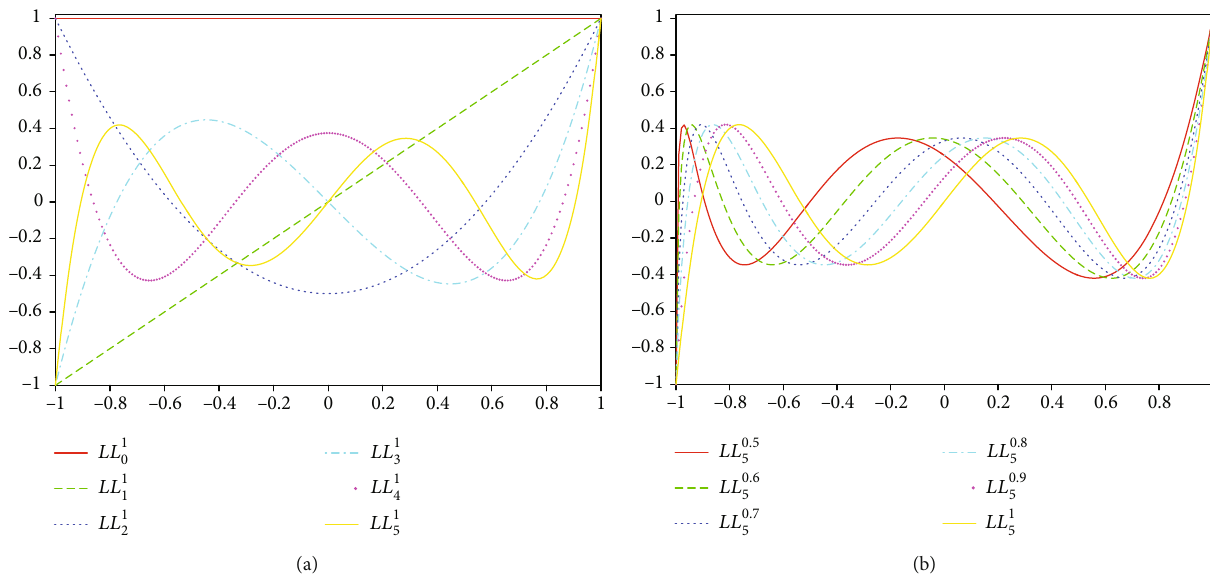
Figure 2: (a) The fi rst six terms of the left SFLPs for α = 1 . (b) The sixth term of the left SFLPs for α = 0 : 5 , 0.6, 0.7, 0.8, 0.9, and